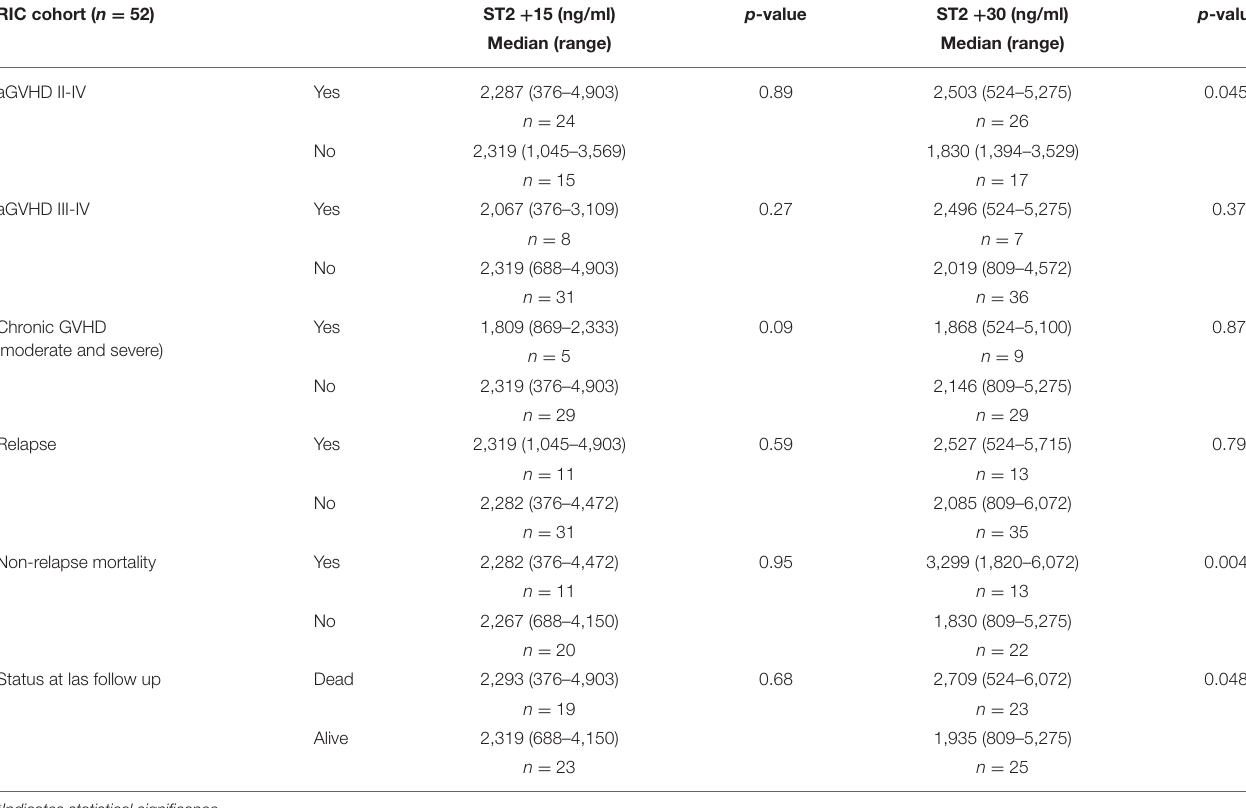
TABLE 3 | Association between ST2 levels at day + 15 and + 30 and GVHD (acute and chronic), NRM, relapse, and OS in the RIC cohort ( n = 52). RIC cohort ( n = 52)